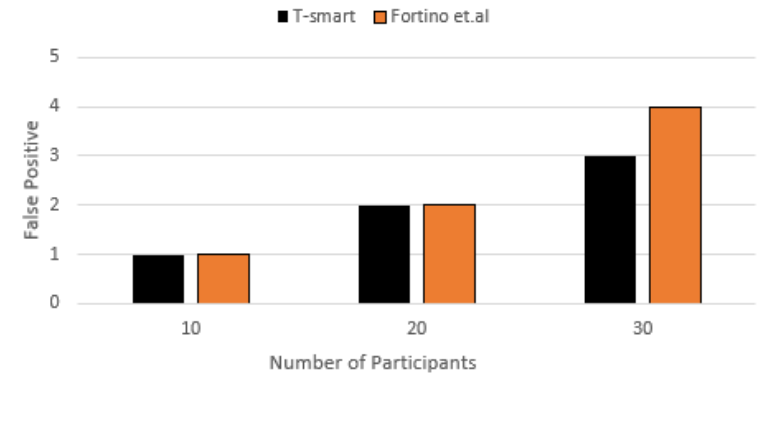
Figure 7. FP with 10–30 participants.